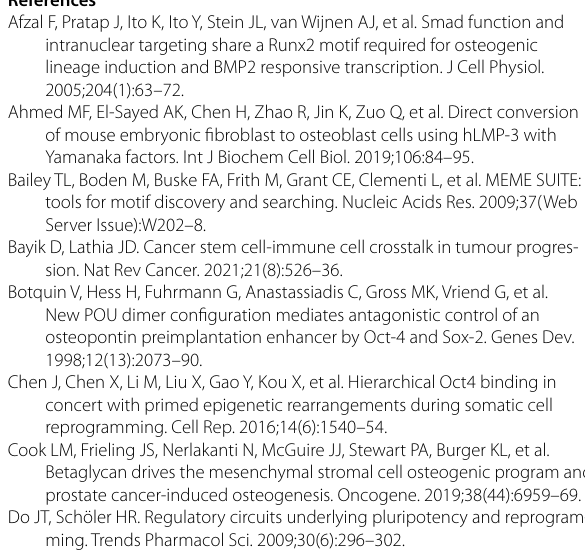
Additional file 5: Table S1. The characteristics of patients with CaOx stones and patients with renal cancers. Table S2. ShRNA sequences designed for silencing OCT4 BMP2 and OLMALINC . Table S3 Primer sequences designed for qRT-PCR. Table S4 . Primer sequences designed for 5’ and 3’ RACE of OLMALINC . Table S5. The details of primary antibodies used in immunoblotting (IB). Table S6. Primer sequences designed for CHIP-qPCR. Table S7. Primer sequences designed for bisulfite sequenc- ing PCR (BSP) of BMP2 promoter. Table S8. The predicted sites in BMP2 or SMAD4 promoter which OCT4 binds to. Table S9. The intersection of OCT4 binding lncRNAs identified by RIP-Seq and upregulated